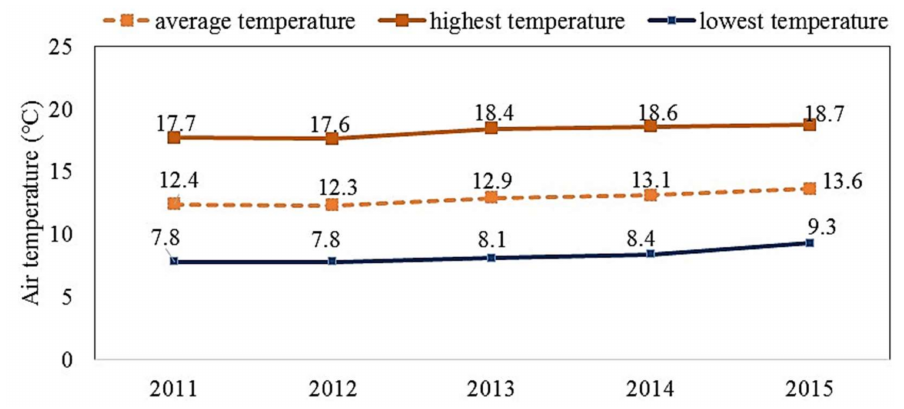
Figure 6. Comparison of the energy use rate (%) in residential and commercial buildings.